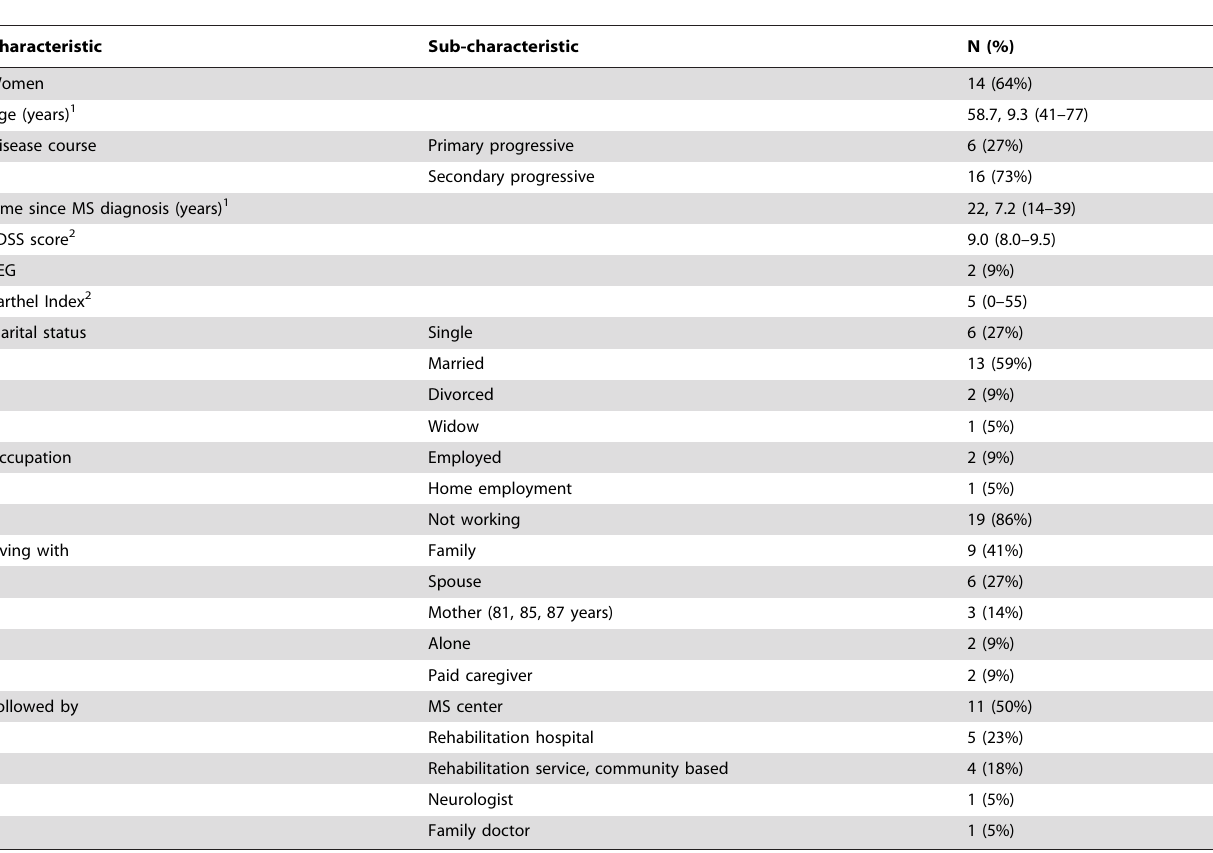
Table 1. Characteristics of the 22 people with severe multiple sclerosis who participated in the personal semi-structured